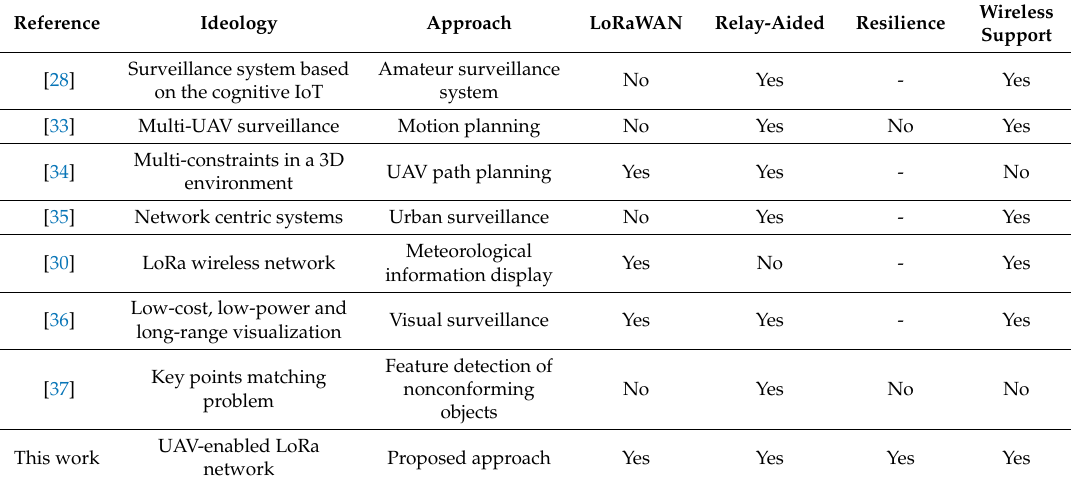
Table 1. Comparison between the state-of-the-art and the proposed Unmanned Aerial Vehicle (UAV)-enabled Long Range (LoRA)